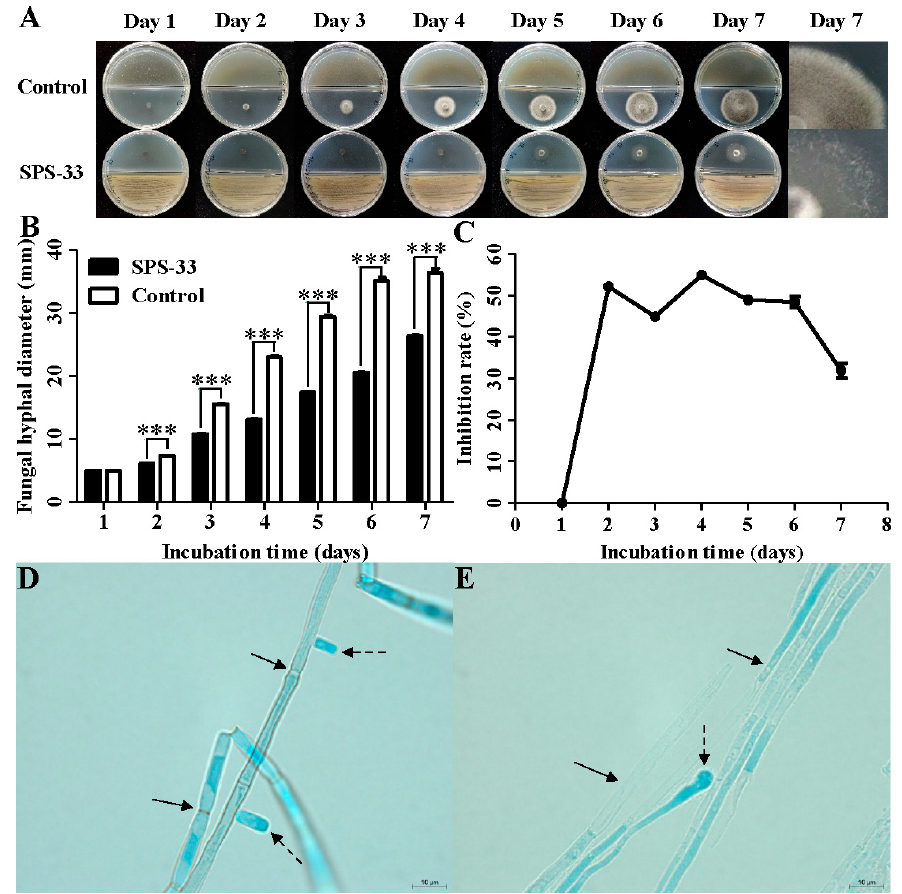
Figure 2. Antifungal effects of VOCs emitted by SPS-33 against C. fimbriata . ( A ) Mycelial growth. ( B ) Inhibitory effects on mycelial growth. ( C ) Inhibition rate. ( D ) Morphological observation of untreated C. fimbriata . Solid-line arrows point to septum, and dashed-line arrows point to spores. ( E ) Morphological observation of SPS-33 treated C. fimbriata. Solid-line arrows point to vacuoles and dashed-line arrows point to abnormal enlargement. Scale bar: 10 µ m. *** denotes significance at P<0.001.